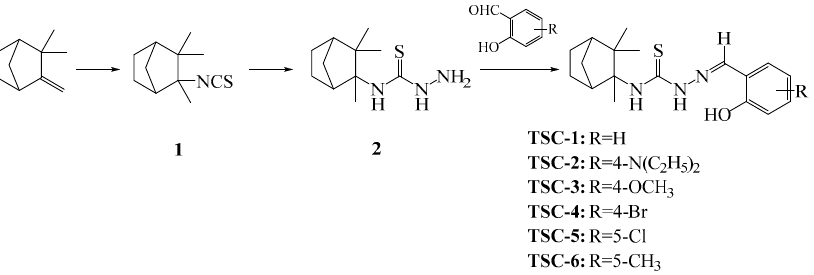
Scheme 1. Synthesis and structures of camphene-based